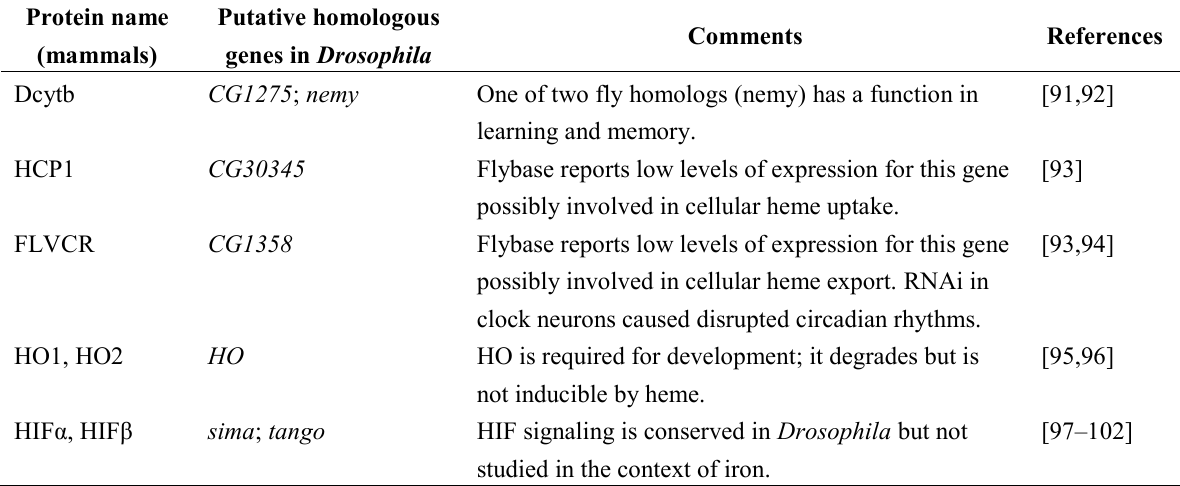
Table 2. Genes with putative functions in Drosophila iron